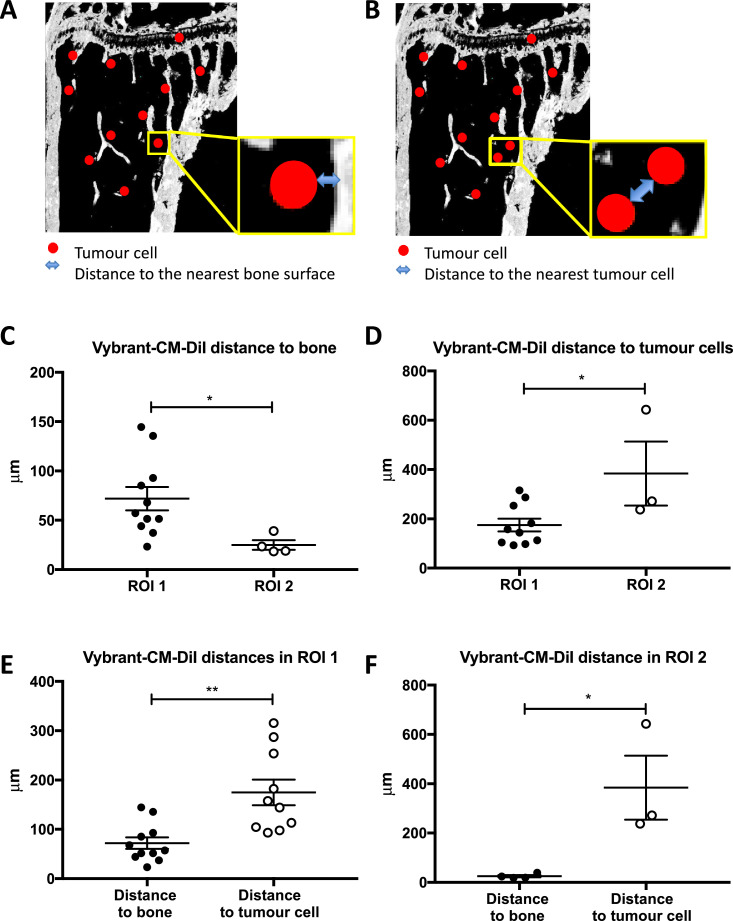
Location of MDA-MB-231-GFP-IV cells in the bone microenvironment. (A) Schematic illustration of the distances measured from the edge of the tumour cells to the nearest bone surface and (B) to the closest other cancer cell. Graphs show the distance of Vybrant-CM-DiI cells to the bone surface (C) and to other tumour cells (D) (n = 11 bones analysed). The comparison between the distances to the bone surface and to other tumour cells in ROI1 is shown in (E) and in ROI2 in (F). *p ≤ 0.05 and **p ≤ 0.01, student's t-test, graphs show mean ± SEM.